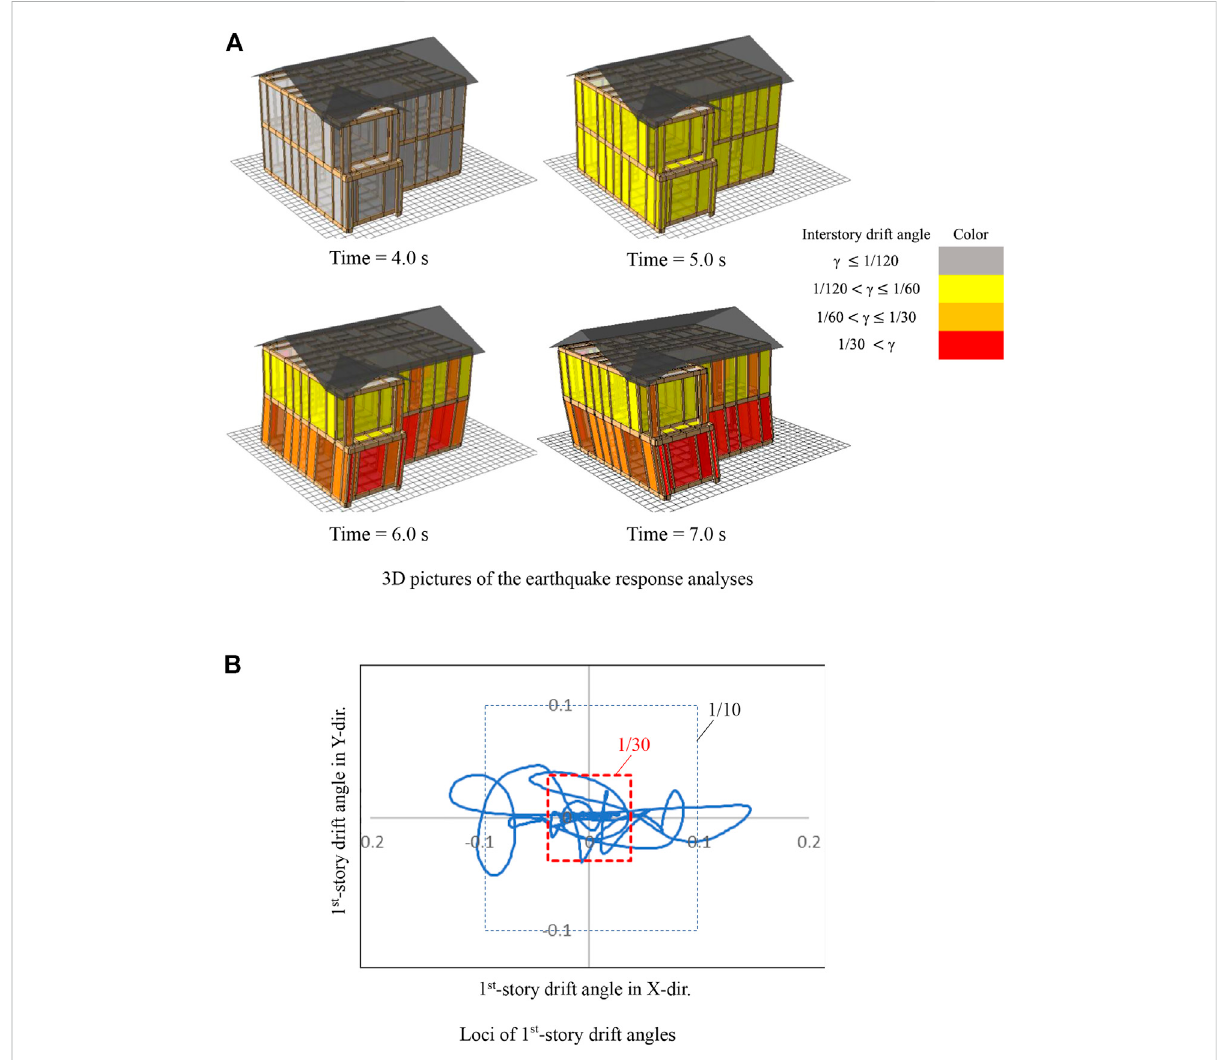
FIGURE 7 Results of the earthquake response analyses of the timber frame house without dampers (100% of the foreshock of the 2016 Kumamoto earthquake) (A) 3D pictures of the earthquake response analyses (B) Loci of fi rst-story drift angles.